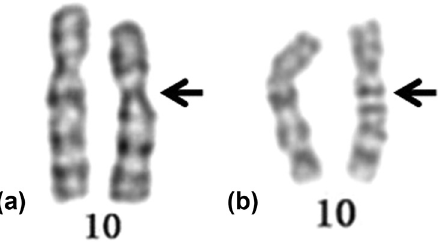
Figure 1: ( a ) Karyotype of the fi rst case and ( b ) karyotype of the second case. The arrows indicate an abnormal